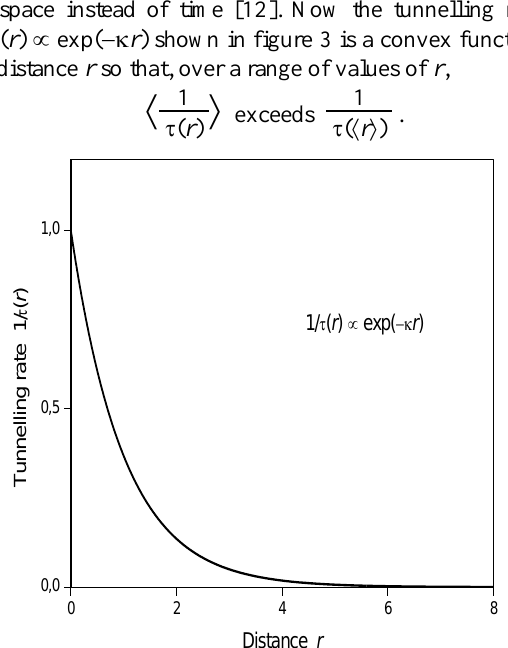
Fig. 3 . The tunnelling rate per unit time 1/  as a function of distance r (arbitrary units).